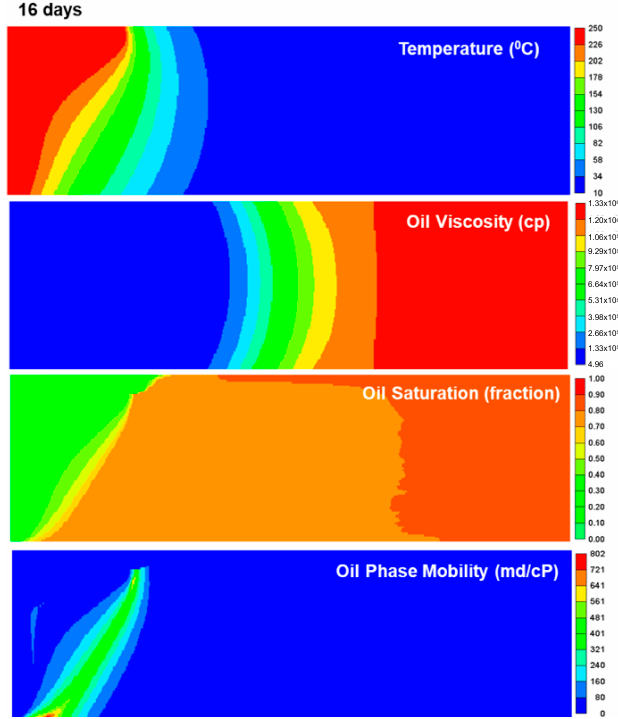
Figure 24. 2D images of the temperature, oil viscosity, oil saturation and oil phase mobility distributions of the HE model after 16 days of steam injection. The height of the image has been exaggerated by two times.